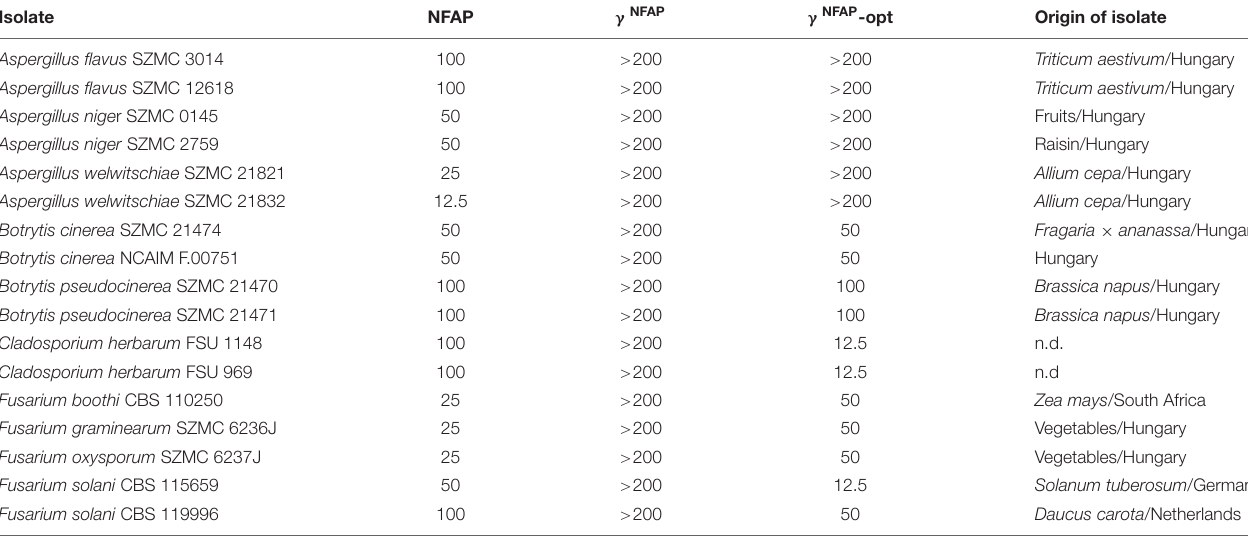
TABLE 1 | Minimal inhibitory concentrations ( µ g ml − 1 ) of Neosartorya fischeri antifungal protein (NFAP), γ NFAP , and γ NFAP -opt peptides against plant pathogenic filamentous ascomycetes. Isolate NFAP γ NFAP γ NFAP